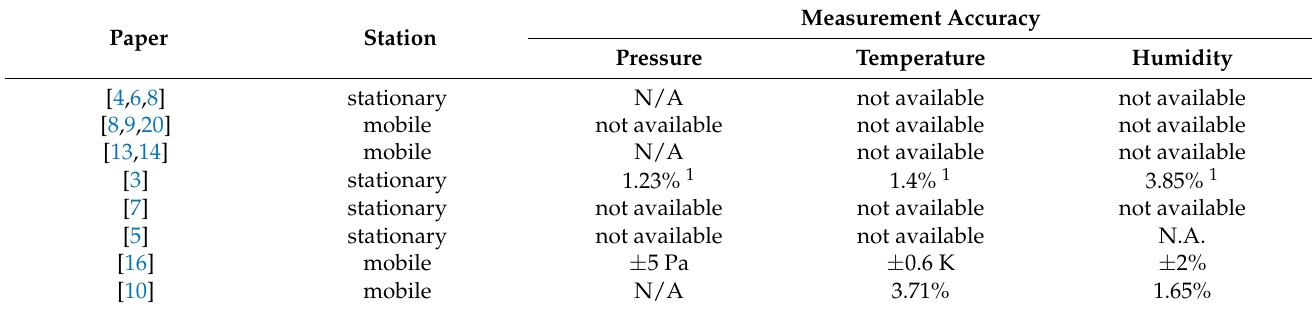
Table 8. Errors reported in related